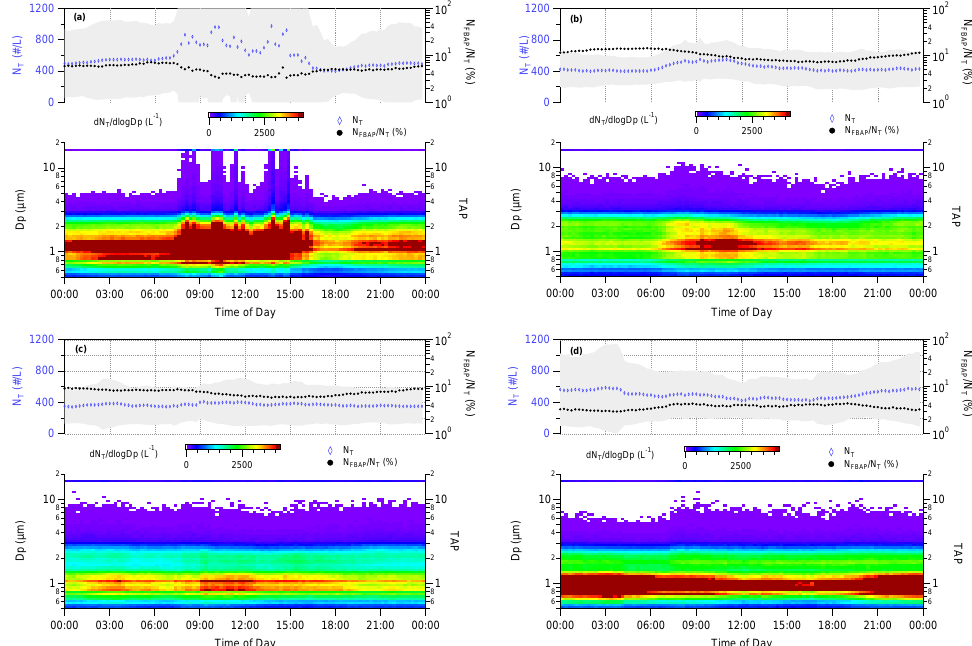
Fig. 10. Diurnal change of TAP number concentrations (upper panel) and size distributions (lower panel) for each measurement period (plots analogous to Fig. 9): (a) spring, (b) summer, (c) autumn, and (d) winter. Light-gray shaded area shows TAP concentration variability as the area between 25th–75th percentile